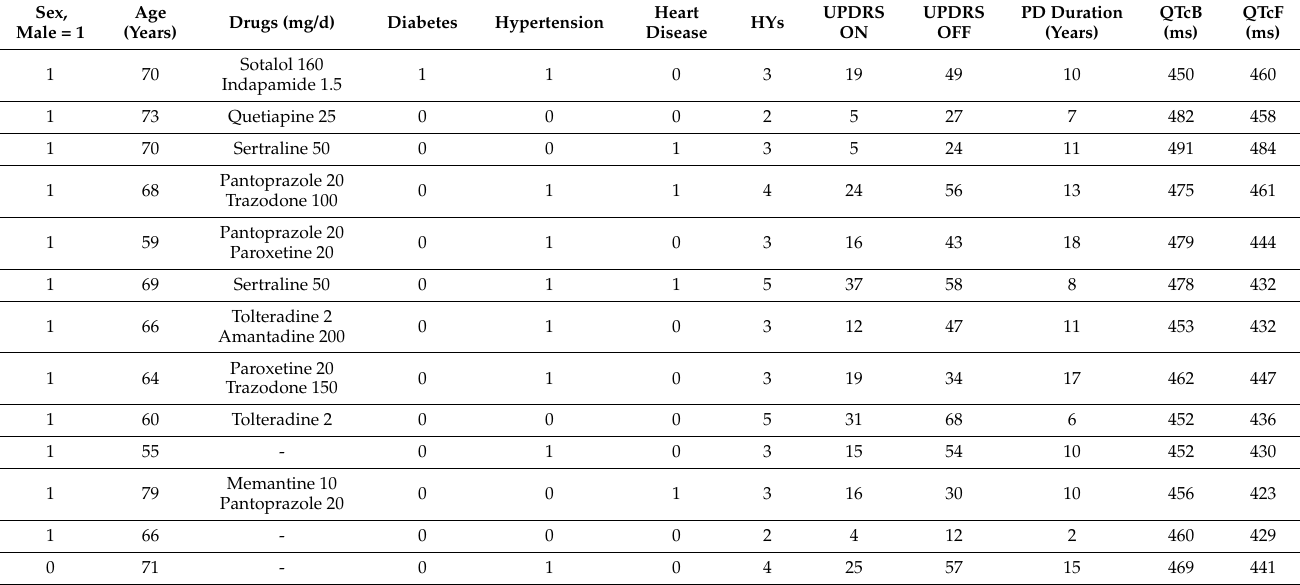
Table 3. Characteristics of patients with long QTcF and/or